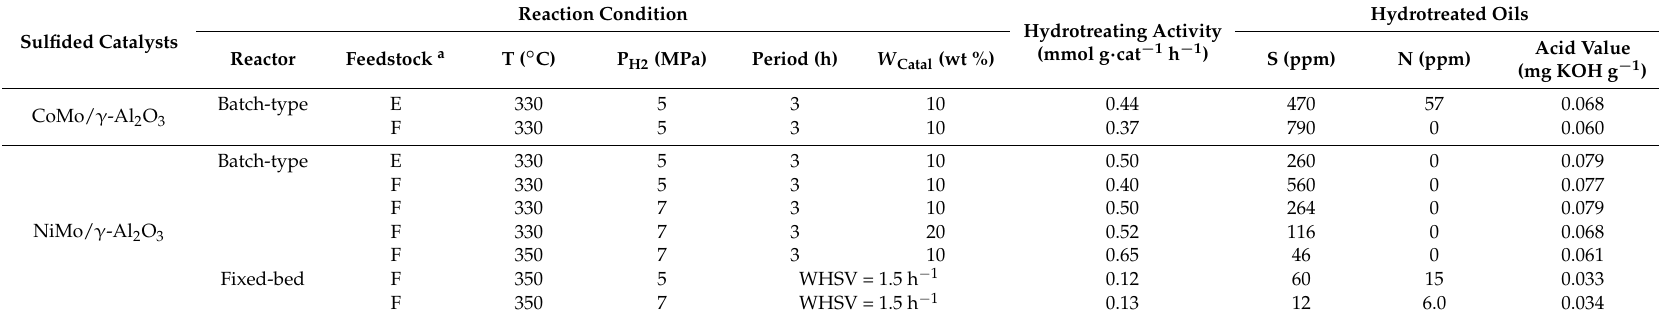
Table 2. Upgrading of Jatropha bio-oil co-fed with the model diesel oil or light gas oil (LGO) over the mesoporous sulfide catalysts.